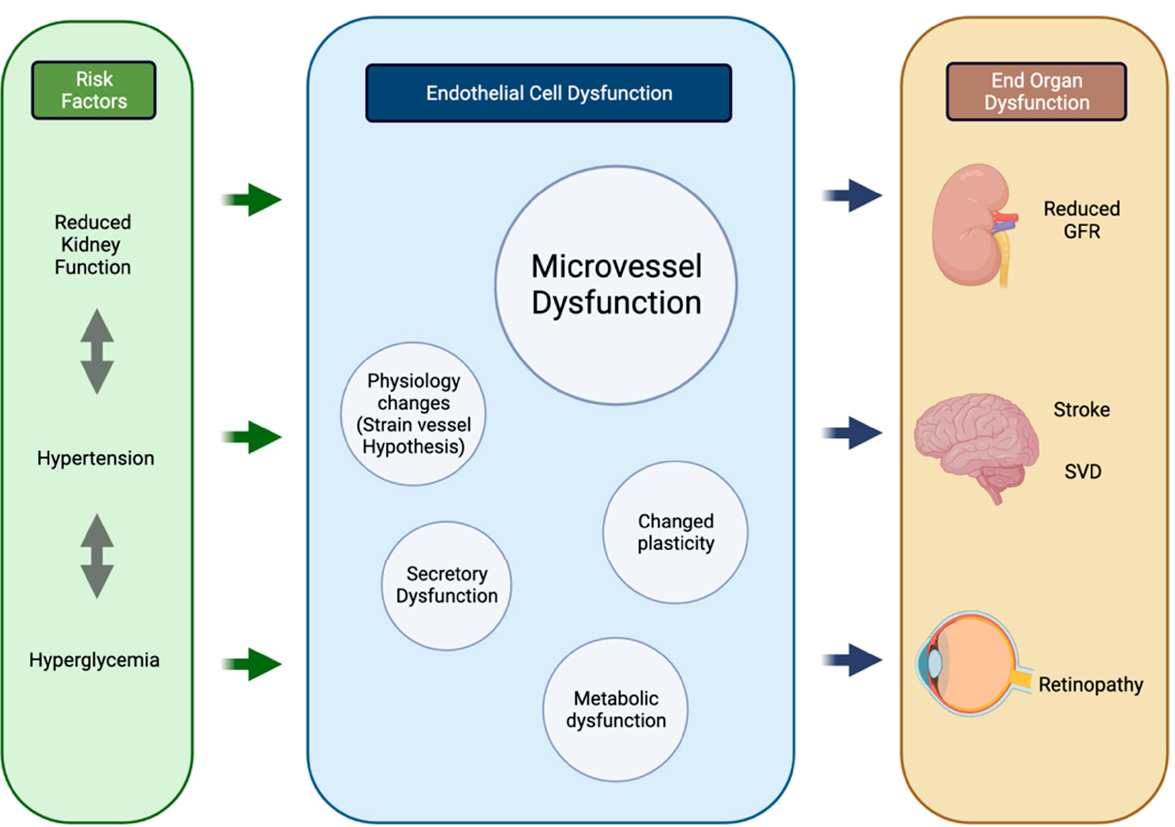
Figure 2. Process of parallel onset end-organ dysfunction. Flowchart demonstrating the interactions between shared systemic risk factors, resulting in endothelial cell changes and end-organ manifestations in the kidneys, brain, and retina. Created using BioRender.com. GFR glomerular filtration rate, SVD small vessel disease. Created using BioRender.com on 25 August